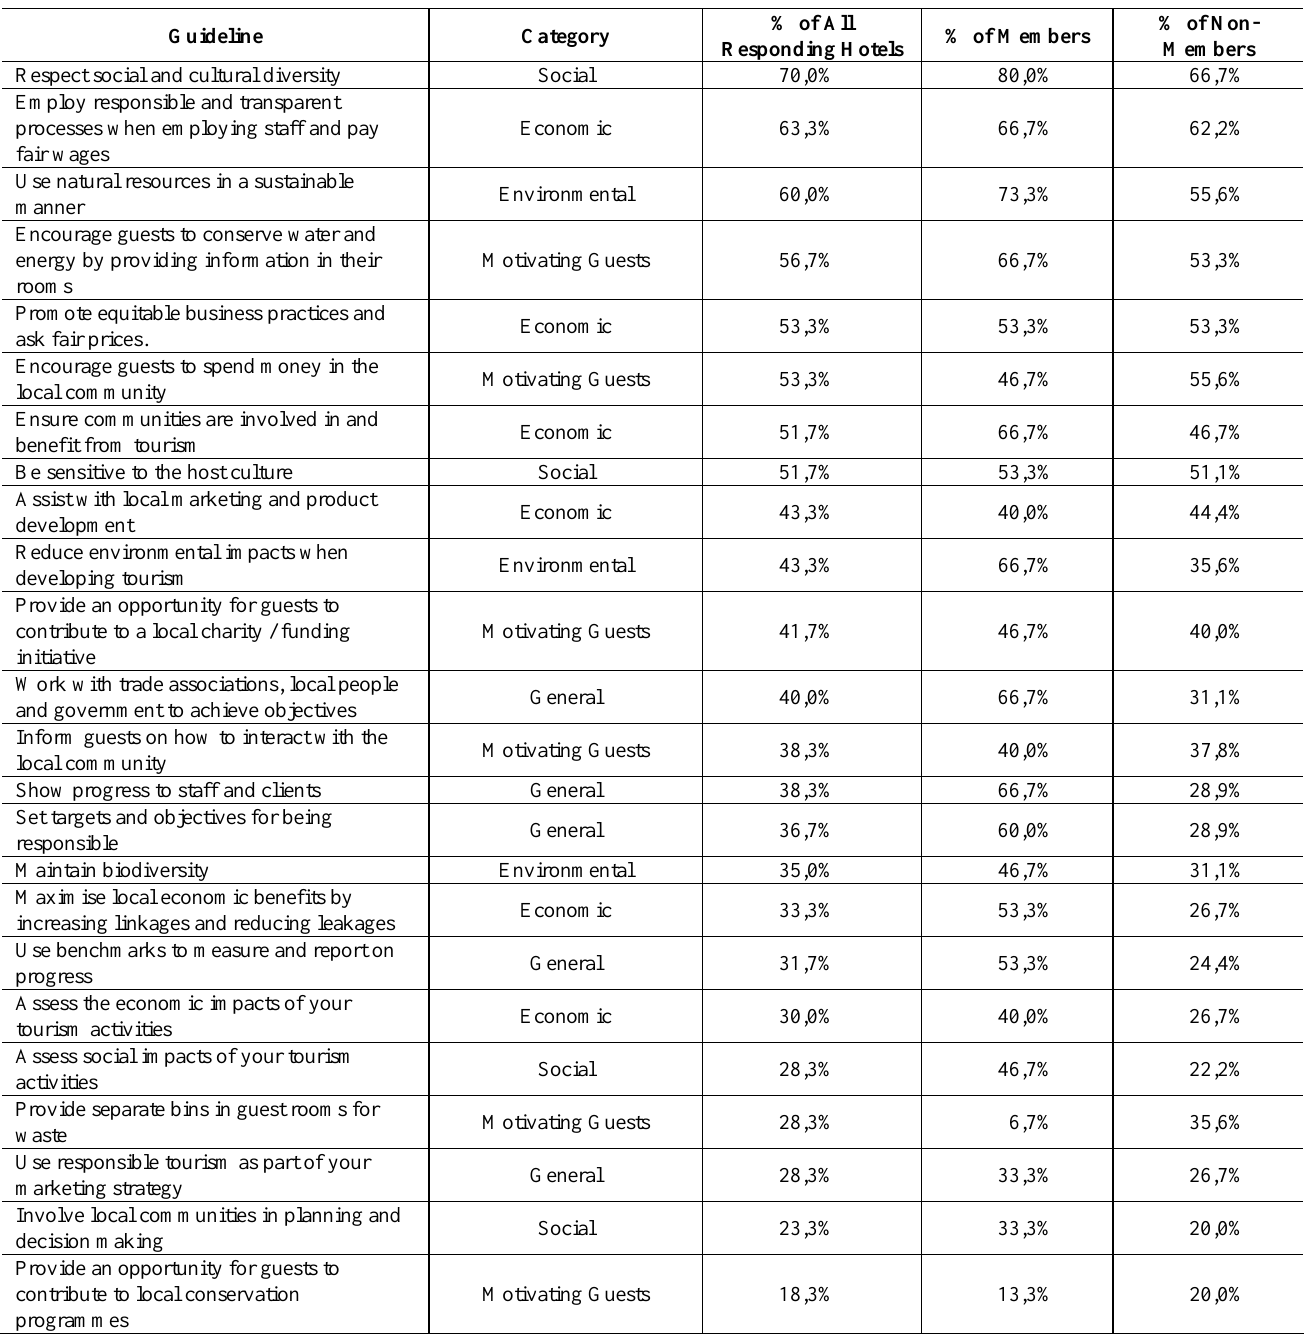
Table 6: Responsible tourism guidelines implemented